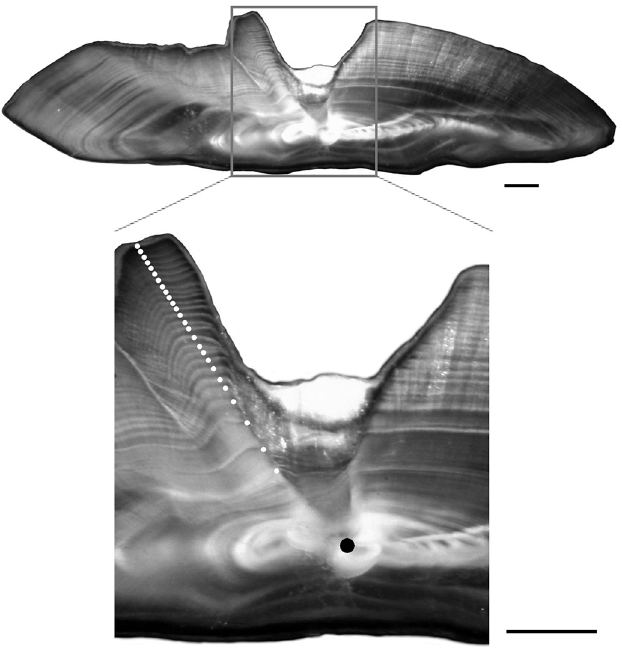
Fig. 7. Thin transverse section of sagitta otolith of a 26 þ years old Pagrus pagrus fi shed in 1976 along southern Brazil. Scale bar 0.5mm. White circles indicate the annuli; black circles indicate the focus.